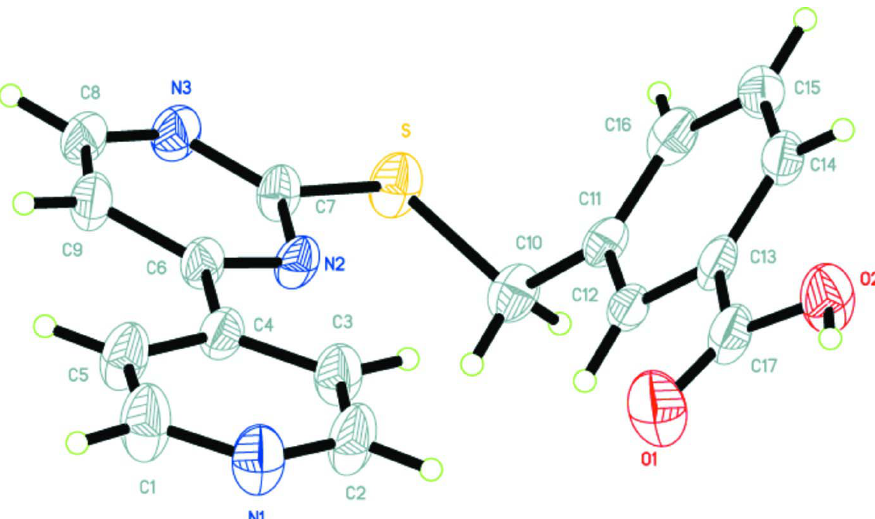
Figure 1 The molecular structure of the title compound with 30% displacement ellipsoids.